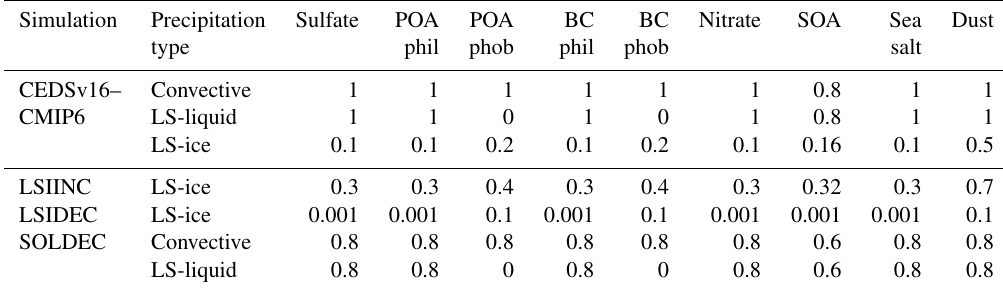
Table 2. Fraction of aerosol mass available for wet scavenging by convective, large-scale liquid, and large-scale ice precipitation in the baseline setup and in the three sensitivity tests. Phil: hydrophilic; phob: